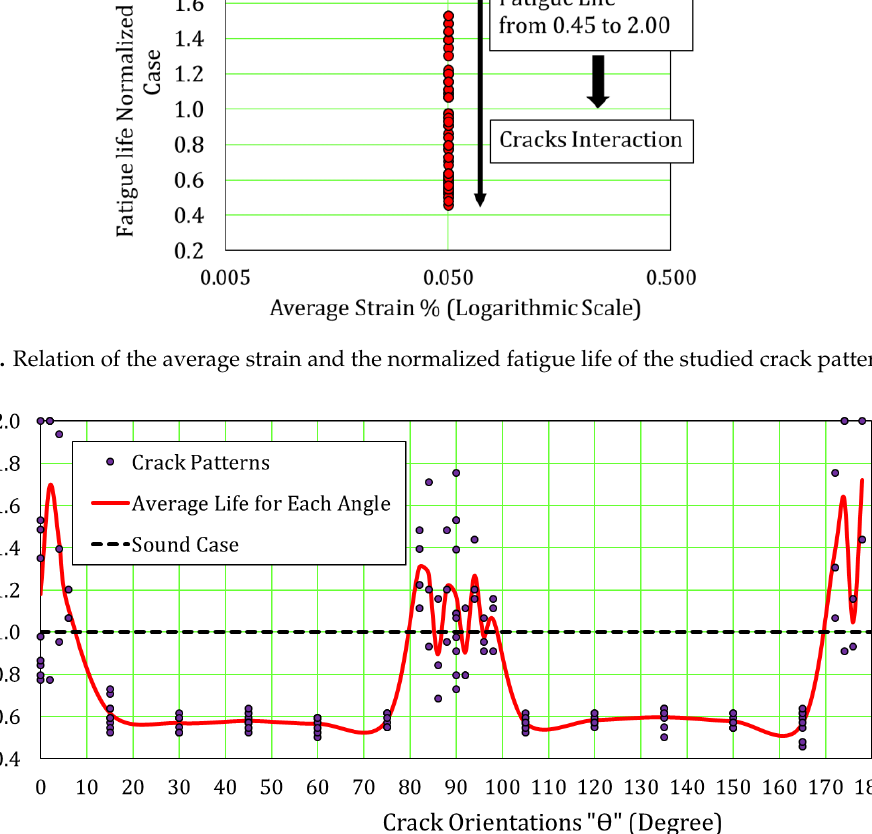
Figure 12. Relation of the crack orientations and the remaining fatigue life.